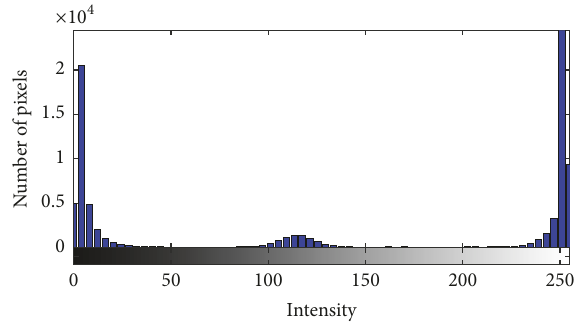
Figure 20: The result of proposed approach on noised image.